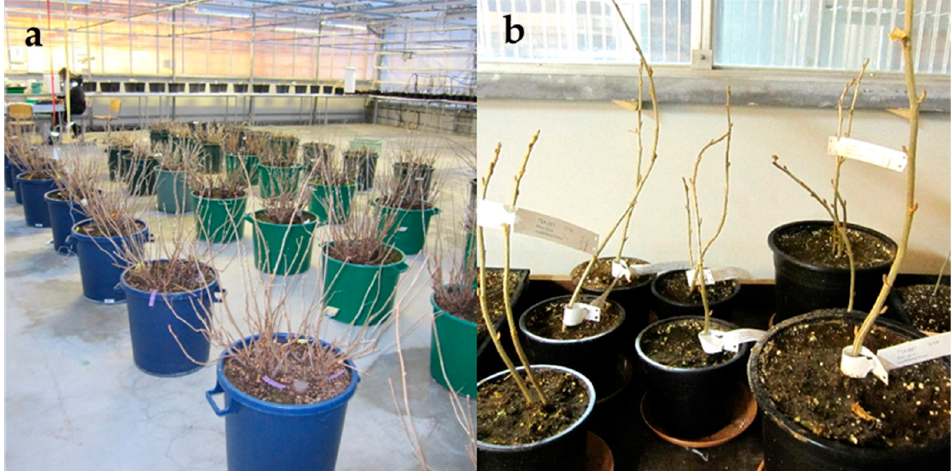
Figure 3. Source plants used for cryopreservation. ( a ) The pre ‐ basic mother plants maintained for plant production. ( b ) Young genebank plants produced for establishment of the new field collection.